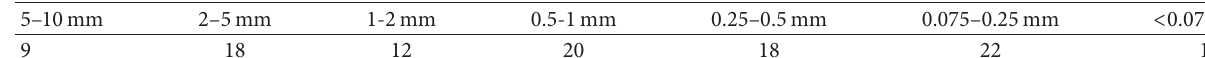
Table 2: Particle size distribution (%).